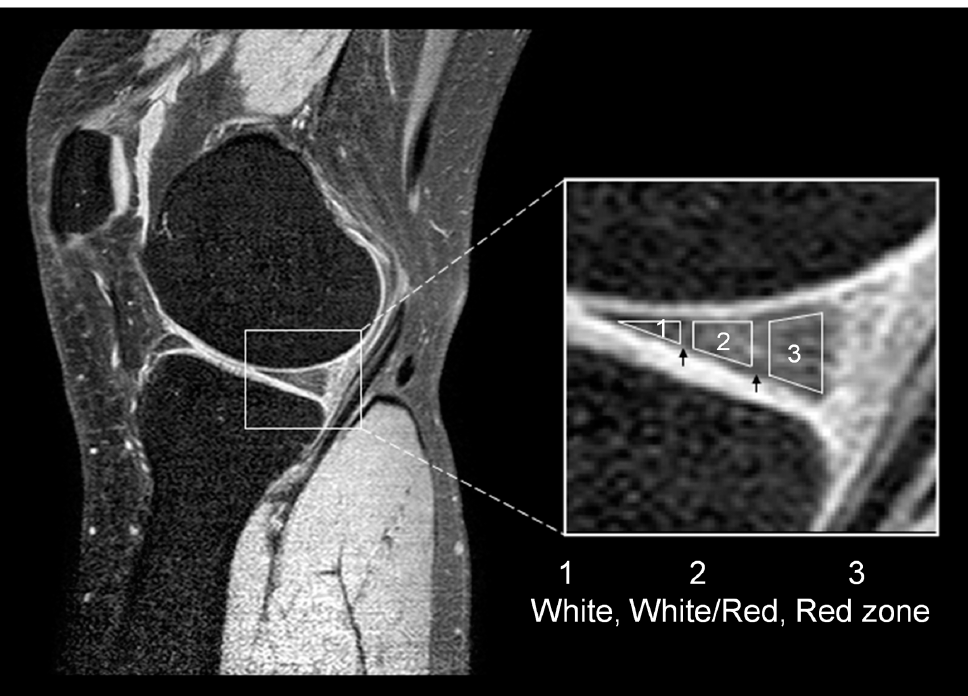
Figure 2. Representative ROIs in a nearly sagittal slice of a knee meniscus are shown. The selection of ROIs was performed on the first- echo MR image, which is enlarged on the right side. The black arrows indicate the separation between the three zones, and each zone was about one-third the width of the meniscus.